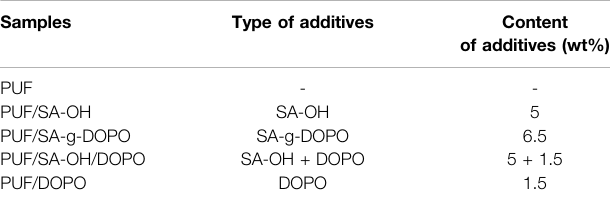
TABLE 1 | PUF compounds and the compositions.